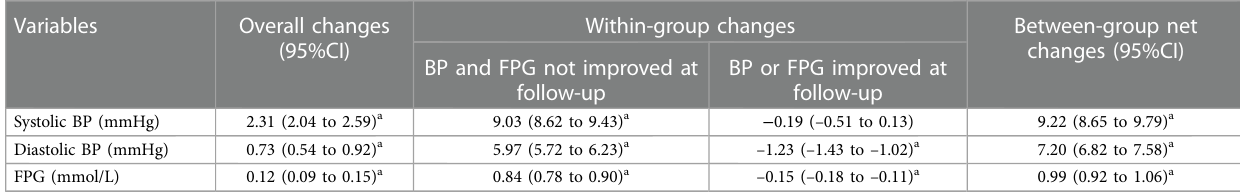
TABLE 3 Changes in blood pressure and fasting plasma glucose between baseline and follow-up. Variables